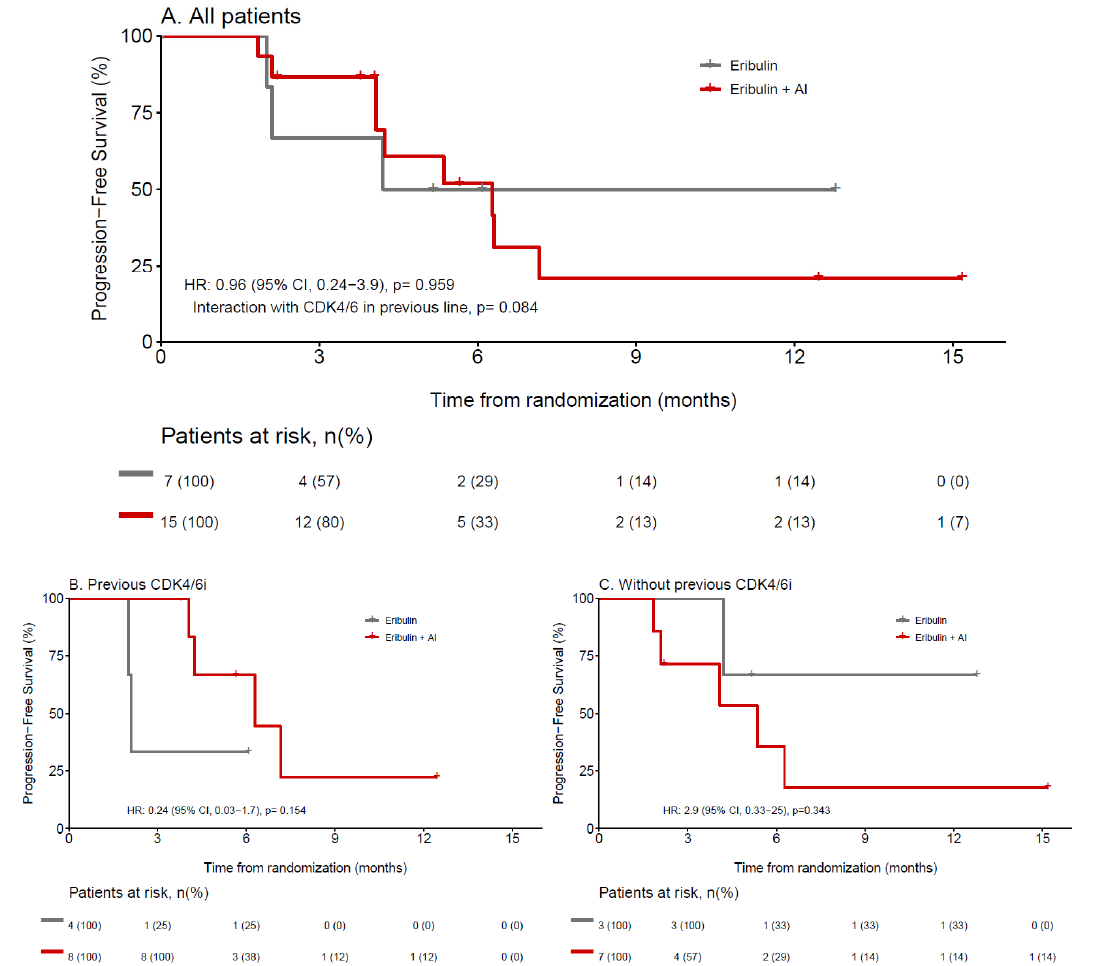
Figure 3. Progression-free survival of patients who received eribulin + AI or eribulin only, according to prior treatment with CDK4/6i. ( A ) All patients, ( B ) CDK4/6I in previous line, ( C ) without previous CDK4/6i in previous line. 95% CI, 95% confidence interval; AI, Aromatase inhibitor; CDK4/6i, Cyclin-dependent kinases 4 and 6 inhibitors; HR, Hazard ratio.